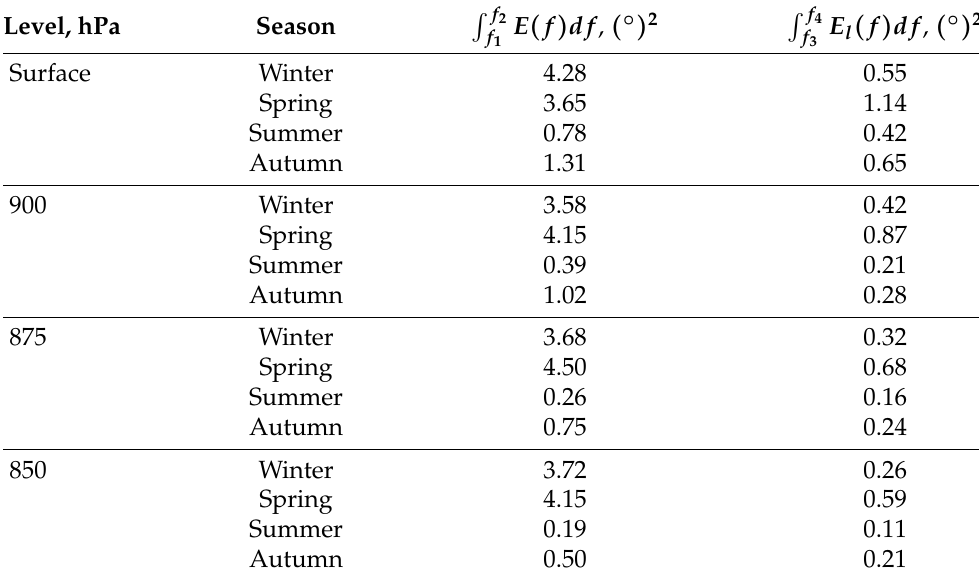
(cid:82) f 2 (cid:82) f 4 E ( f ) df and E l ( f ) df at the Hoa Lac observatory. f 1 f 3